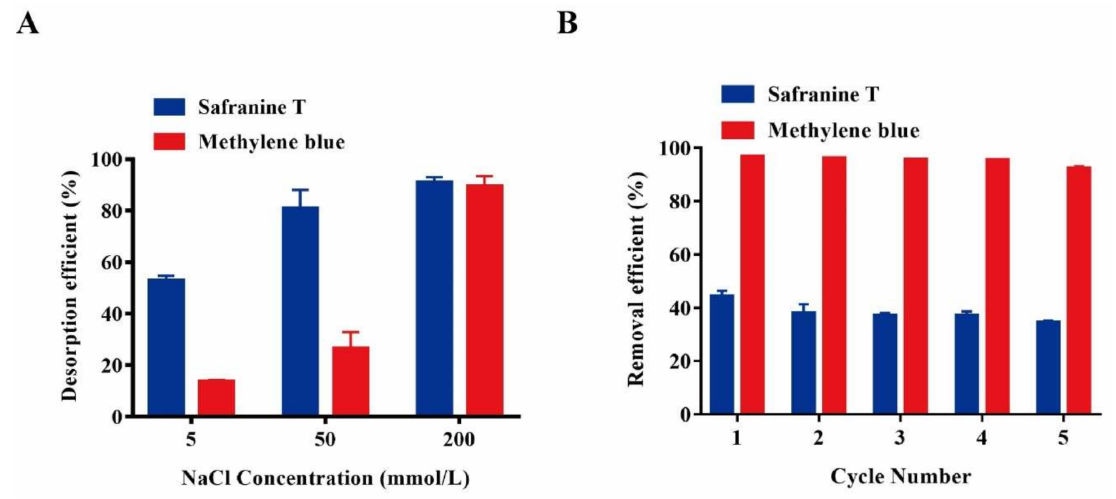
Figure 7. Effects of NaCl concentrations on desorption ( A ) and reusability adsorption ( B ) of Bio-SeNPs. Data are presented as mean ± SD of three